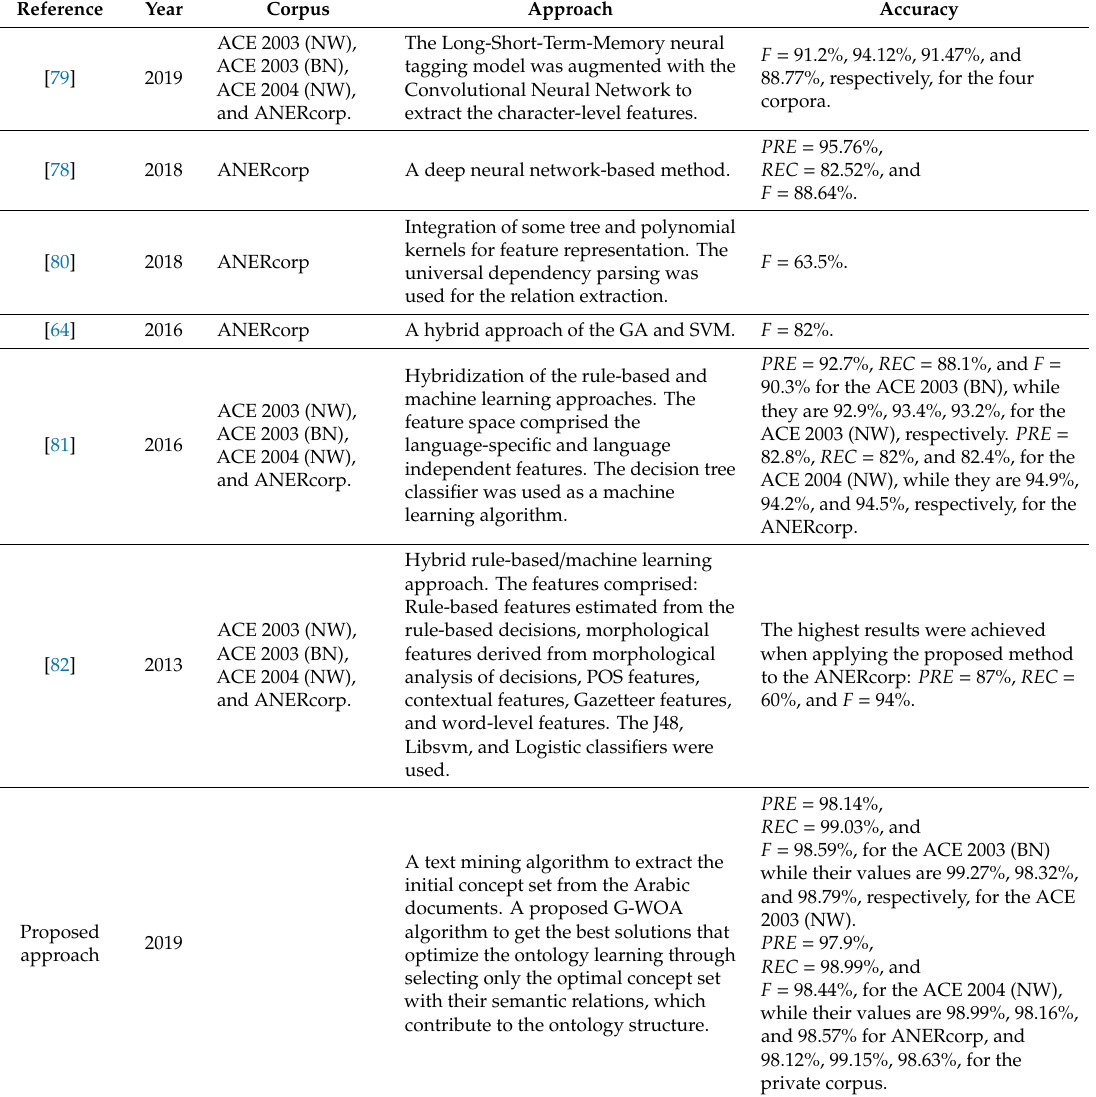
Table 6. Comparison to the state-of-the-art on Arabic ontology